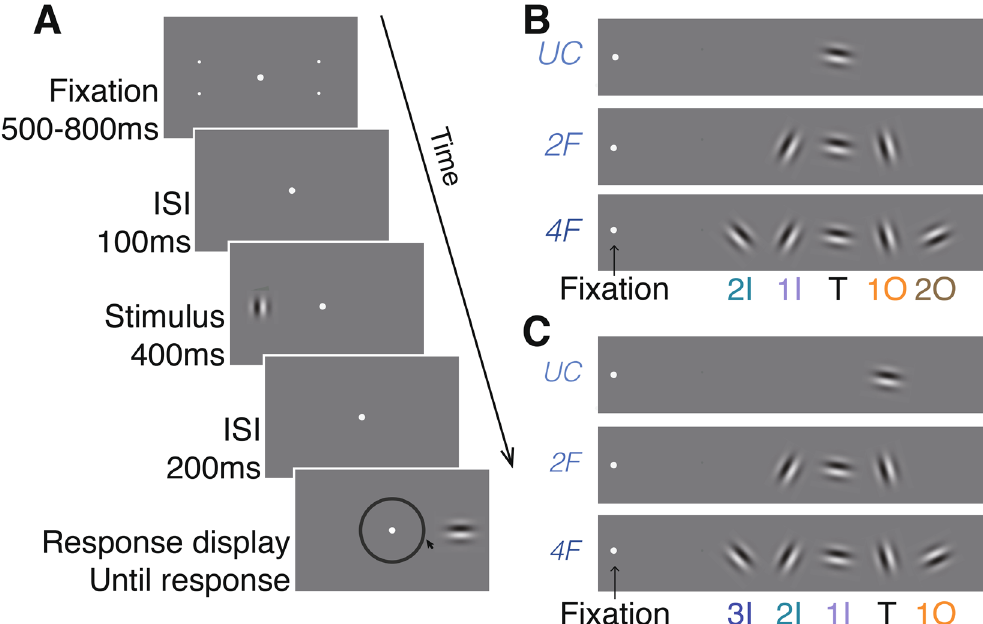
Figure 1. Stimulus type and crowding conditions. ( A ) Illustration of the sequence of events within a trial. During the fixation display, two pairs of dots, one pair in each hemifield, indicated the two possible locations (eccentricity) of the target. Observers estimated the orientation of the Gabor target by pointing the mouse cursor on a wheel. ( B ) The three stimulus conditions in “Experiment 1”. In “Experiment 1” the target was always the intermediate Gabor, whereas in ( C ) “Experiment 2”, the target was the Gabor located one position out from the intermediate position. 3I 3rd inner flanker, 2I 2nd inner flanker, 1I 1st inner flanker, T target, 1O 1st outer flanker, 2O 2nd outer